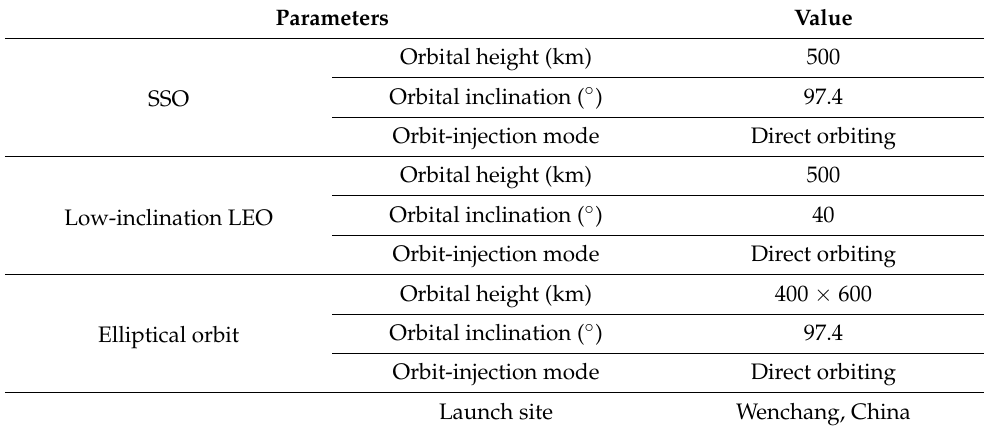
Table 2. Standard mission.